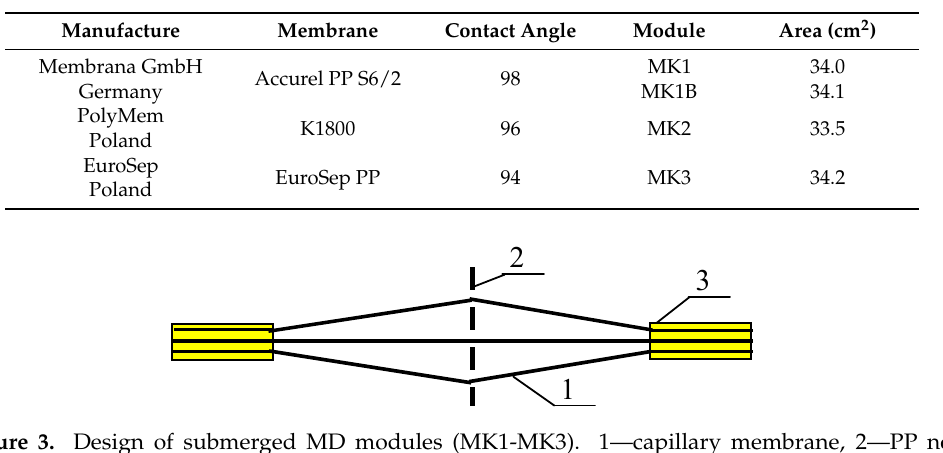
Table 1. Commercial membranes assembled in MD modules applied for the study.